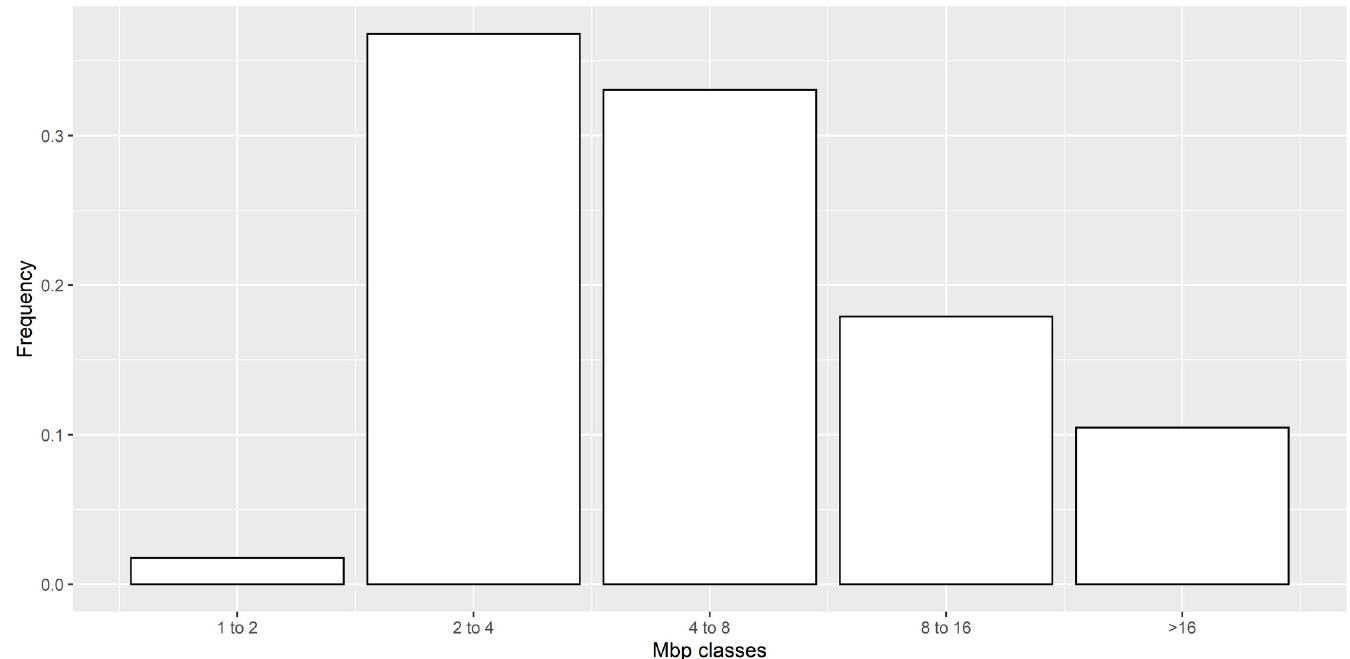
Fig 1. Frequencies of Runs of Homozygosity (ROH) according to segment size in Mb. ROH were calculated for 176 British Lop samples and 44,315 SNPs and classified based on their